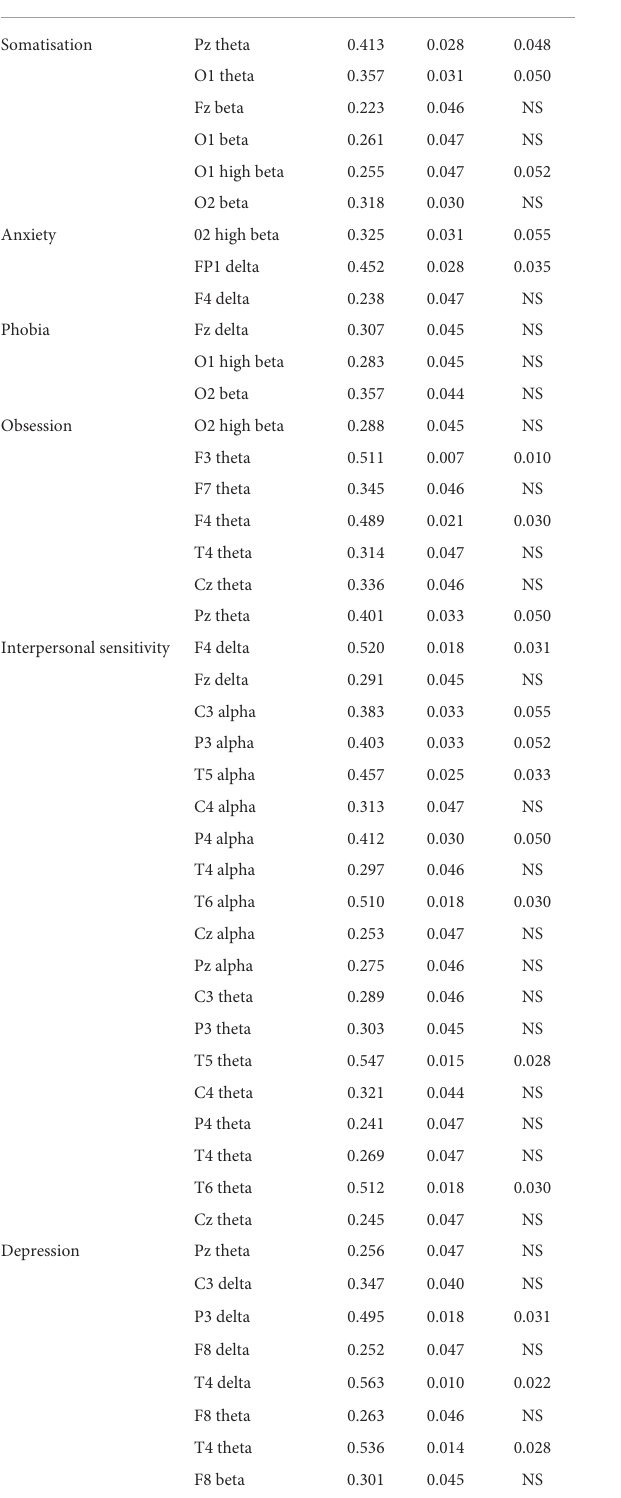
TABLE 2 Correlations between QEEG spectral power density and psychiatric symptomatology (Scl-90-R) in affective disorders. Frequences r p FDR p